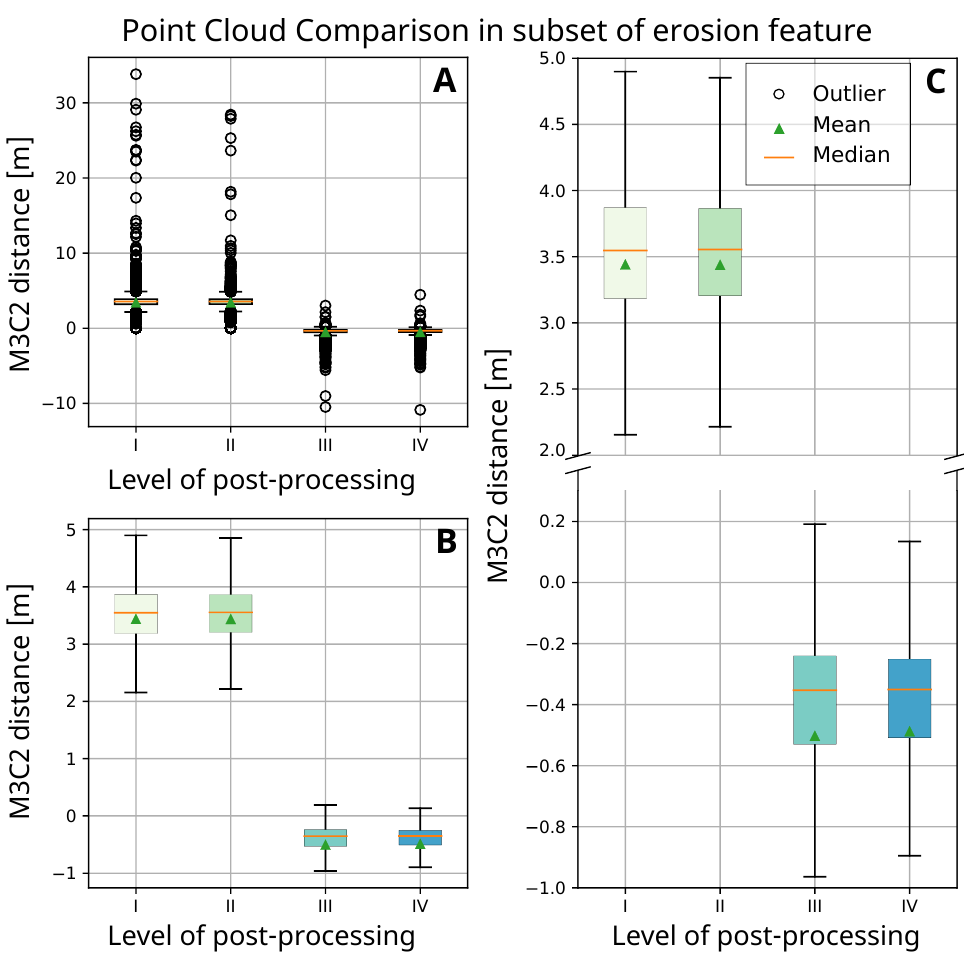
Figure 6. Cloud distances derived via Multiscale Model to Model Cloud Comparison (M3C2) in the point cloud subset of the erosion feature. Results are grouped according to the levels of post- processing (I) raw, (II) denoised (III) denoised + ICP aligned, (IV) denoised + AROSICS shifted + ICP aligned data. Boxplots (25% and 75% percentile) ( A ) with and ( B ) without outliers and ( C ) close-up on median, mean and percentile